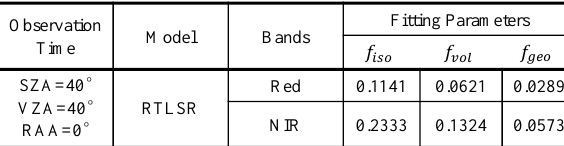
Table 1. Kernel parameters ( 𝑓 RTLSR model using the MODIS MCD43A1.